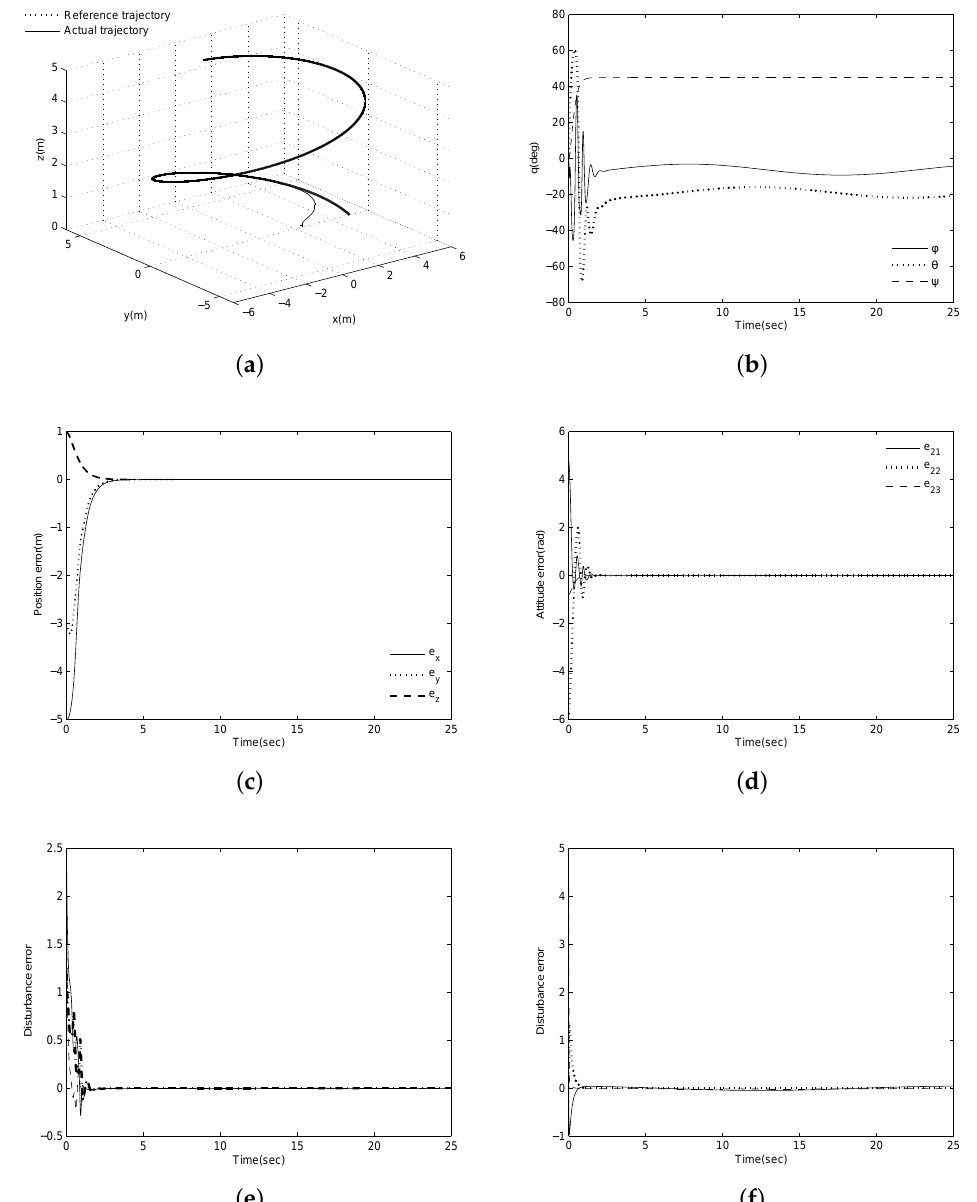
Figure 2. Tracking results of the proposed method: ( a ) Three-dimensional trajectory; ( b ) Euler angles q ; ( c ) Position tracking errors; ( d ) Attitude tracking errors; ( e ) ˜ d (solid: ˜ d 1 , dashed: ˜ d 2 , dotted: ˜ d 3 ); ( f ) ˜ τ d (solid: ˜ τ d 1 , dashed: ˜ τ d 2 , dotted: ˜ τ d 3